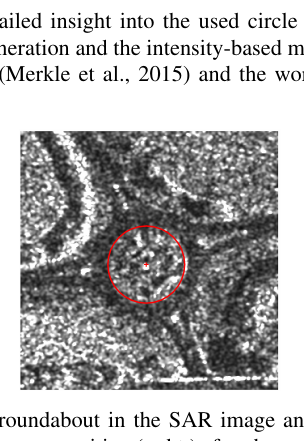
Figure 1: Overview of the proposed method.